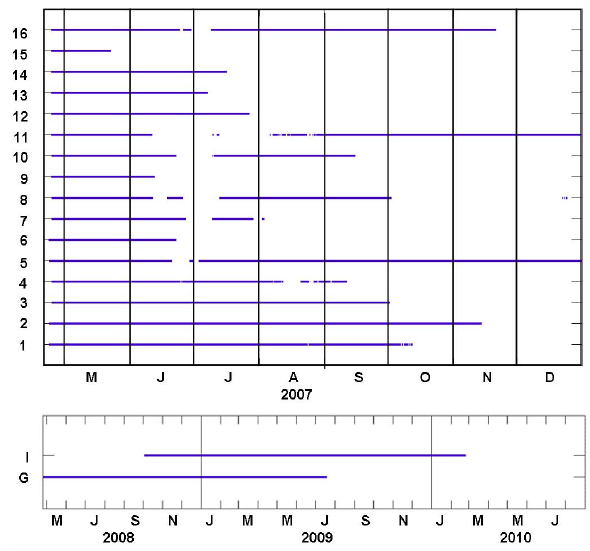
Fig. 2. Data availability for all 16 CALIB buoys in 2007 (top) and of PAWS buoys G, I in 2008–2010